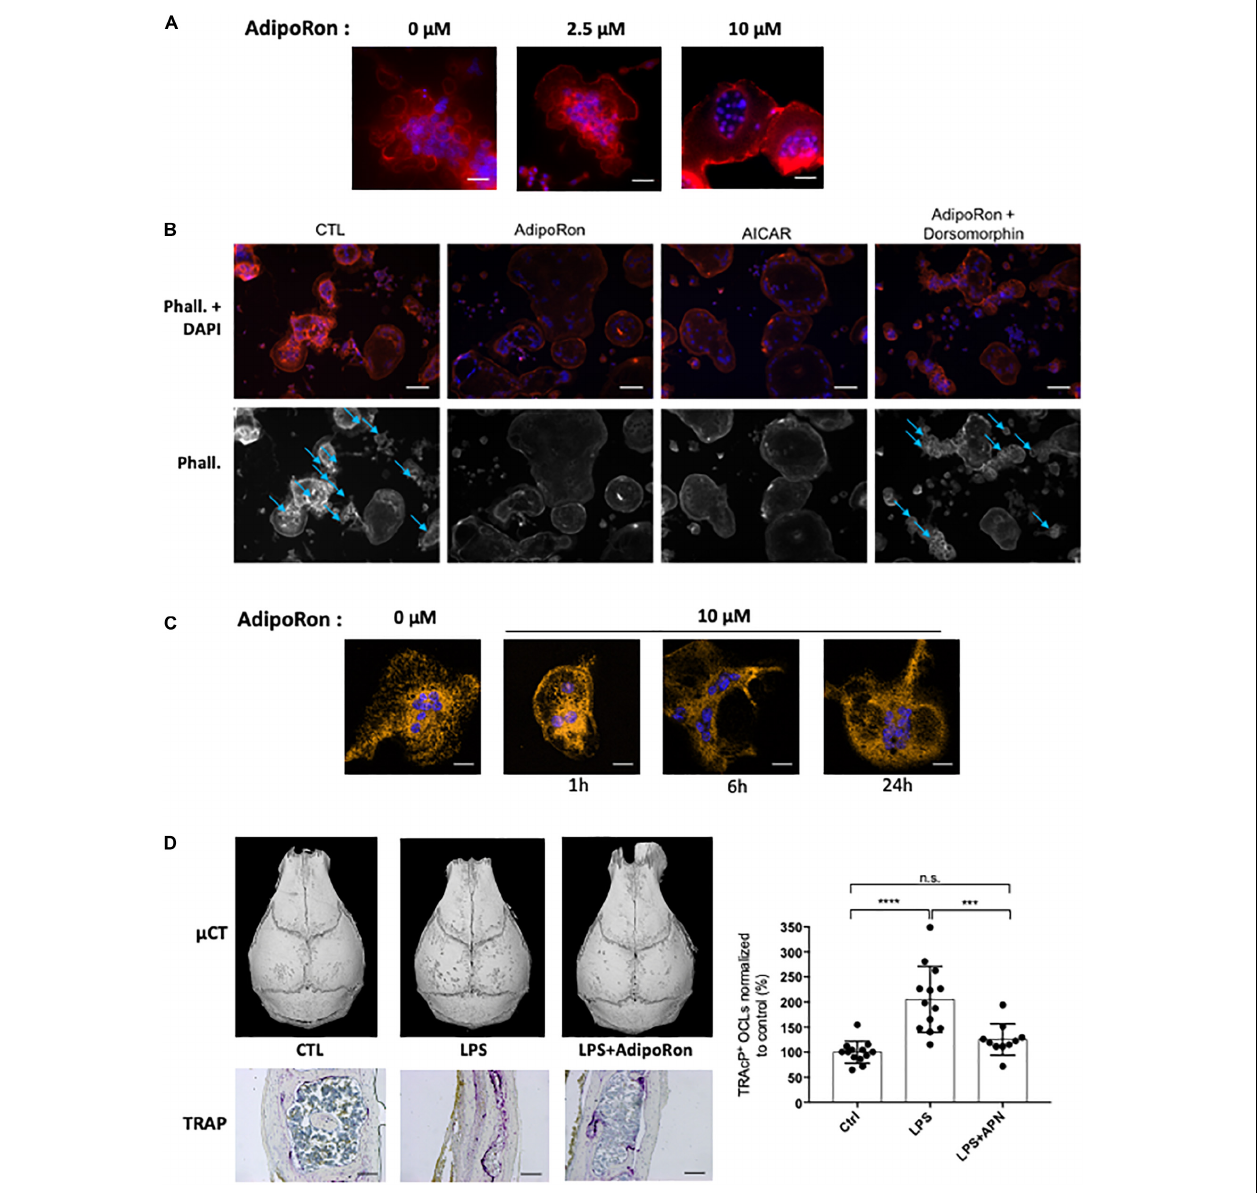
FIGURE 5 | Adiponectin regulates OCL activity and podosome formation. (A) Confocal microscopy of phalloidin-marked podosomes in RAW264.7-OCL in the presence of increasing concentrations of AdipoRon (representative images of n = 3 per concentration) Scale bars = 100 µ m. (B) Confocal microscopy of phalloidin-marked podosomes in the presence of AMPK modulating drugs (AdipoRon, 10 µ M; AICAR, 50 nM; Dorsomorphin, 1.2 µ M) (representative image of n = 3 per conditions white asterisks marking the podosomes). Scale bars = 50 µ m. Blue arrows indicate podosome rings. (C) Confocal microscopy of MitoTracker Orange in mature RAW264.7-OCL after AdipoRon (10 µ M) challenge at different time points. Scale bars = 20 µ m. (D) Mice received daily s.c. injections on the calvaria. Mice were injected with either 100 µ g lipopolysaccharide from Salmonella abortus equi (LPS), or 100 µ g LPS + 500 ng AdipoRon (LPS + AdipoRon) or vehicle (PBS) injection (control, CTL). Mouse skulls were collected on the 3rd day ( n = 3 animals per group); Top panels: Micro-CT of the mouse skulls; Bottom panels: TRAcP staining of mouse skull after LPS + / − AdipoRon challenge, (representative sections from 3 animals per group), scale bars = 100 µ m. Right panel: quantification of the TRAcP staining. Two-group comparisons were performed using the Student’s t-test. ∗∗∗ p < 0.001, ∗∗∗∗ p < 0.0001.